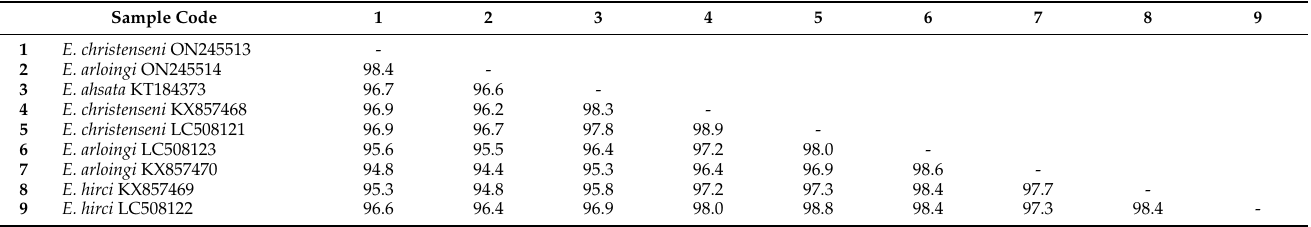
Table 3. Pairwise identities (%) among the COI sequences of E. christenseni and E. arloingi , E. ahsata , and E. hirci